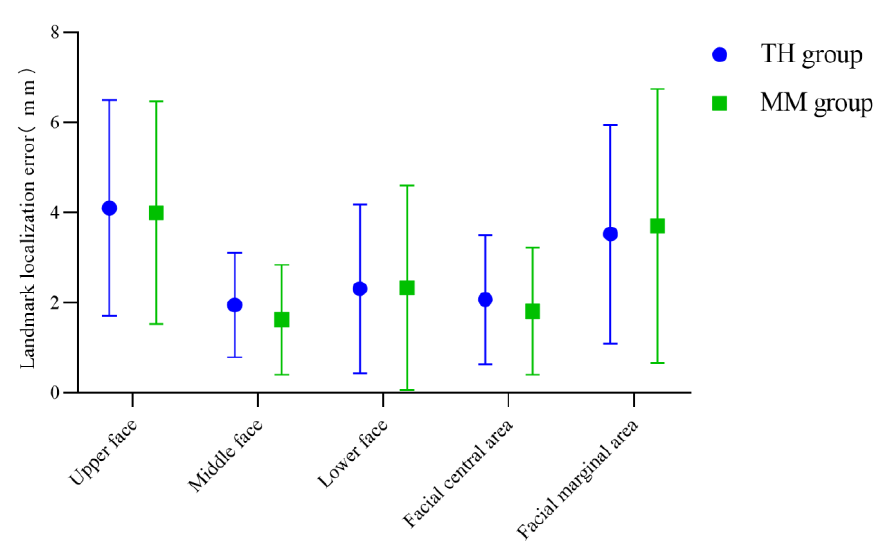
Figure 7. Landmark localization errors in the TH and MM groups based on facial area.